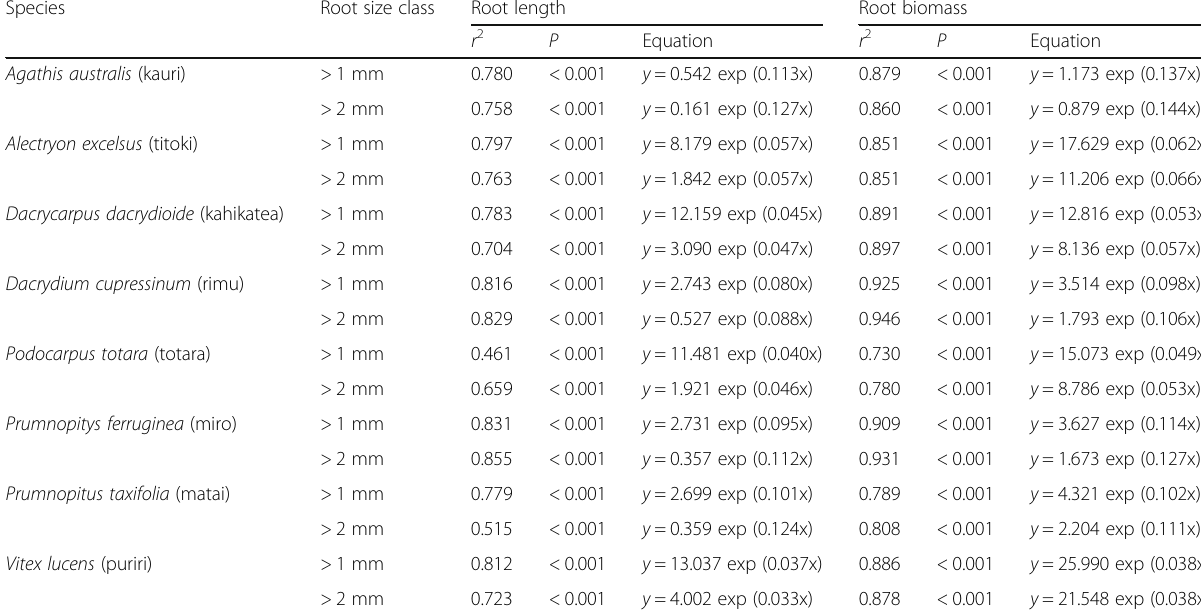
Table 3 Allometric relationships between RCD and total root length, and total root biomass for roots > 1 mm and > 2 mm diameter